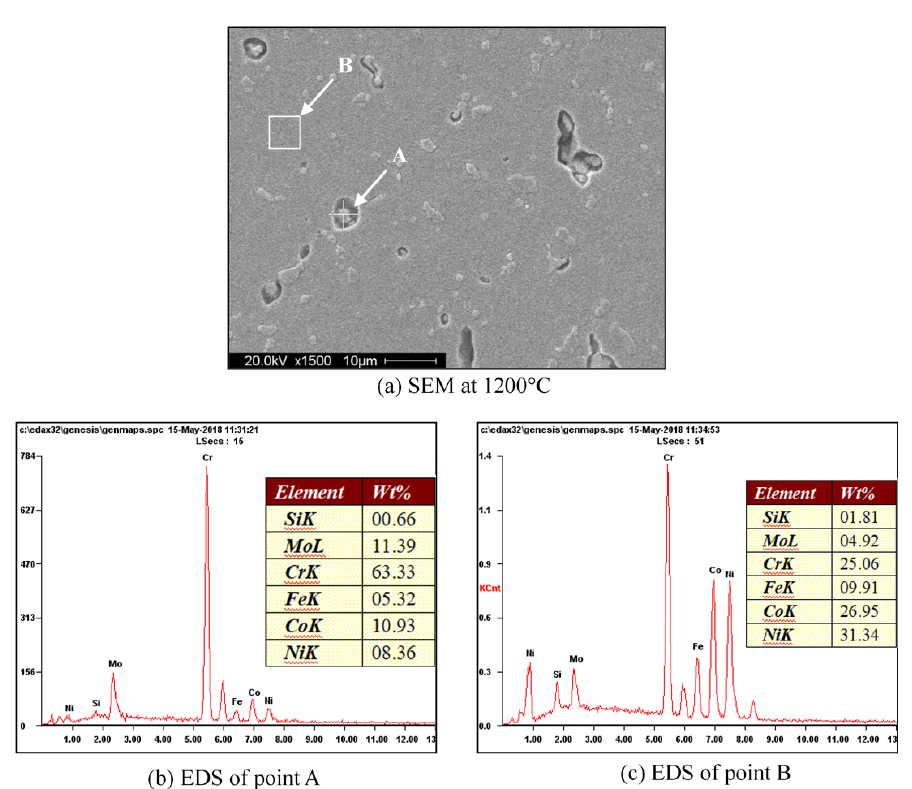
Figure 4. SEM and EDS of CoNiCrMo alloy for 1h at 1200°C solid solution